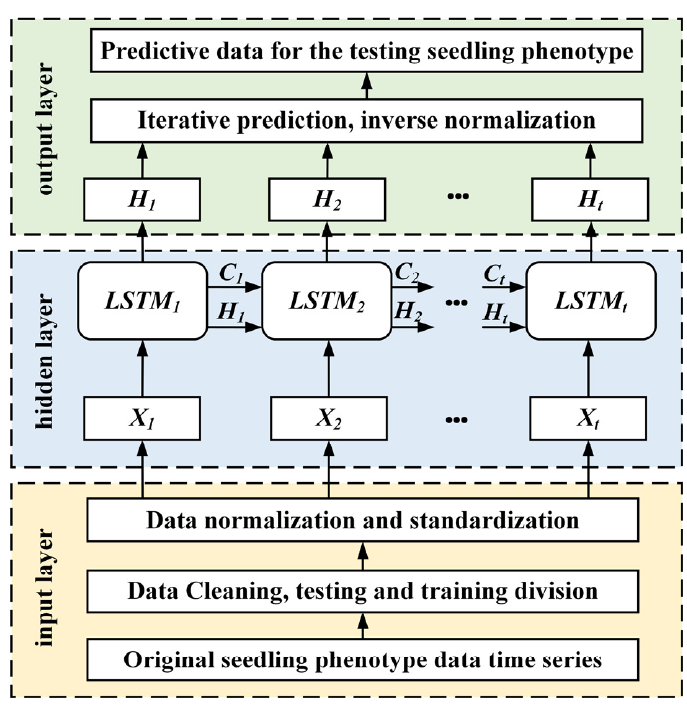
Figure 9. Watermelon seedling growth time series LSTM prediction model.